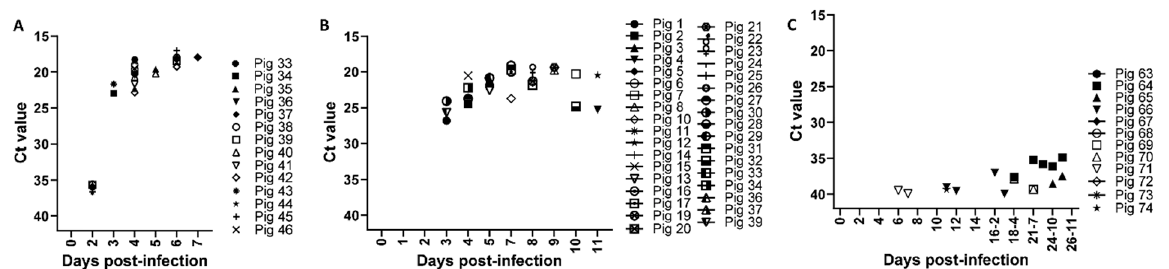
Figure 2. ASFV genomic material in whole blood samples from pigs infected with ASFV Malawi LIL 18/2, ASFV Estonia 2014, or ASFV OURT/88/3. Groups of pigs ( n = 12–39) were infected oronasally with 1 × 10 5 TCID 50 ASFV Malawi LIL 18/2 ( A ), 2 × 10 5 TCID 50 ASFV Estonia 2014 ( B ), or 1 × 10 5 TCID 50 ASFV OURT/88/3 ( C ); on the indicated dpi, whole blood samples from the pigs were collected and assessed for ASFV genomic material using real-time PCR. For the ASFV OURT 88/3 group (C), pigs were re-infected with a dose of 1 × 10 6 TCID 50 ASFV OURT 88/3 on 14 dpi. Ct value of ≤ 35.99, positive. Dead pigs were excluded from the analysis.